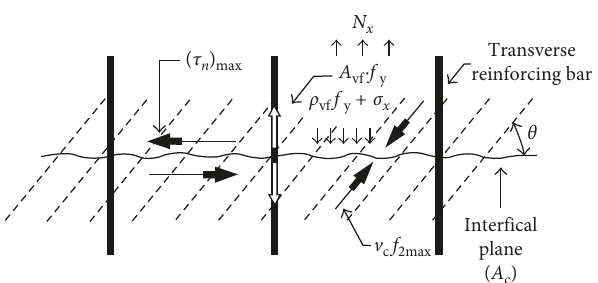
Figure 5: Idealized strut-and-tie action at the construction joints.